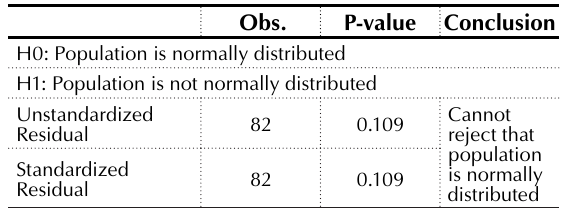
Table 7. Shapiro-Wilk test results